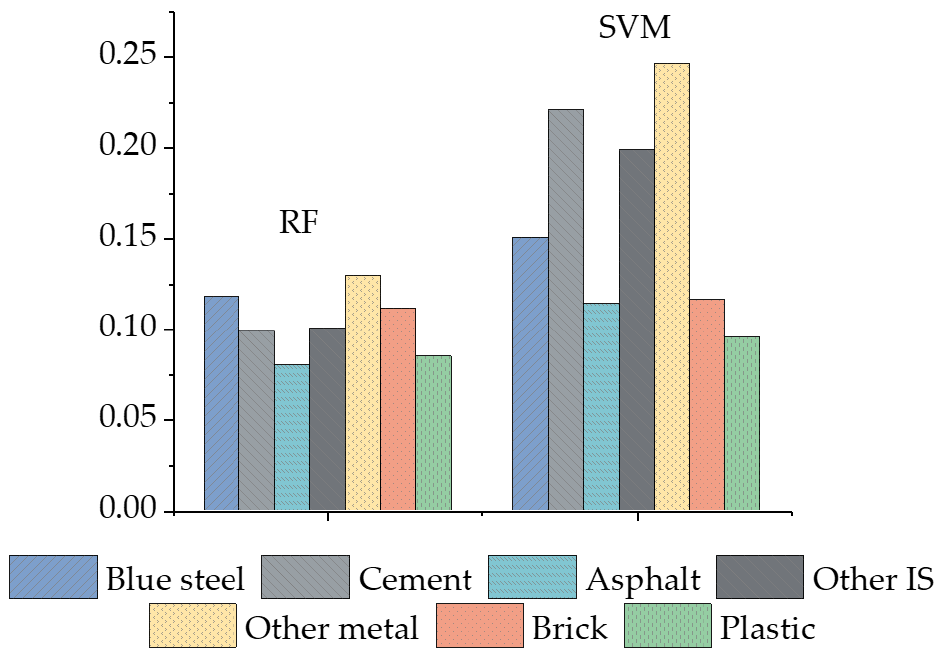
Figure 10. RMSE results of each class compared with random forest (RF) and support vector machine